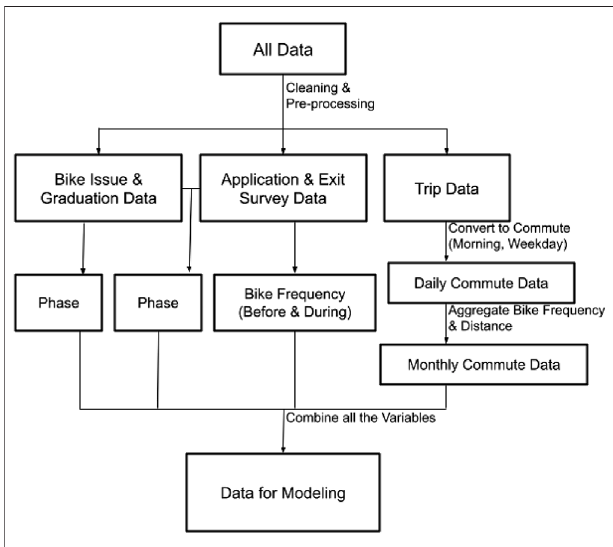
FIGURE 1 | Data cleaning and synthesis